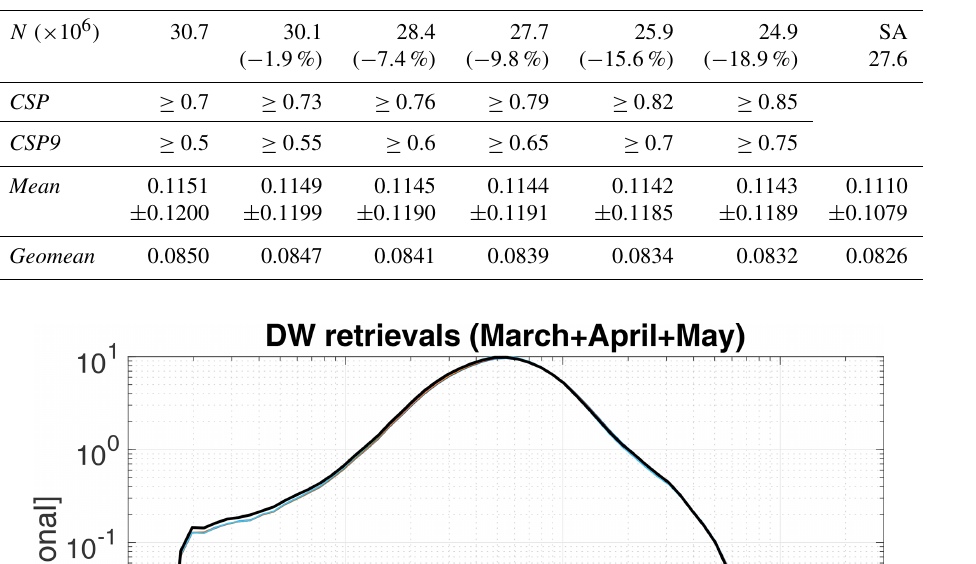
Table 2. Additional statistics for the data presented in Fig. 4. Values for CSP and CSP9 indicate their corresponding thresholds for screening AOD retrievals. The arithmetic mean values are accompanied by their respective ± 1 standard deviations.